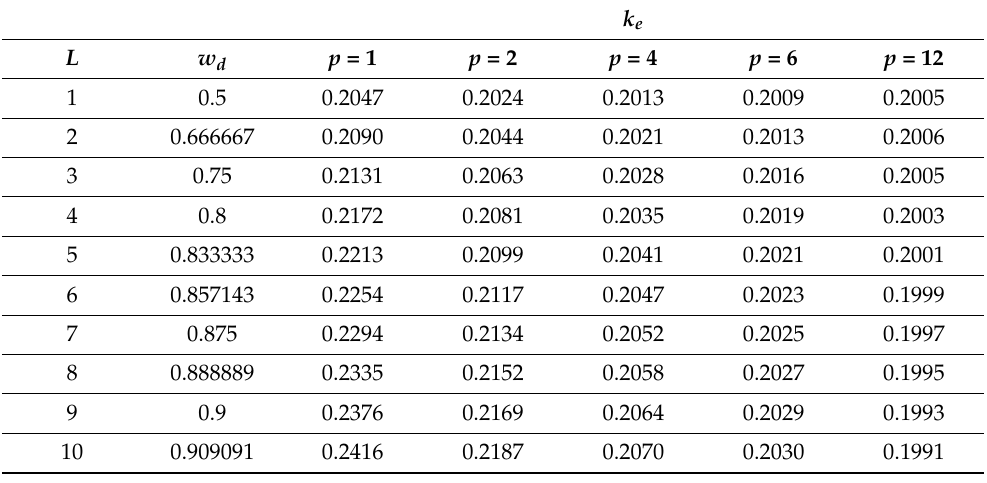
Table 7. Dependence of the equity cost, k e , on leverage level L at different frequency of payments of tax on profit p for six-year company.